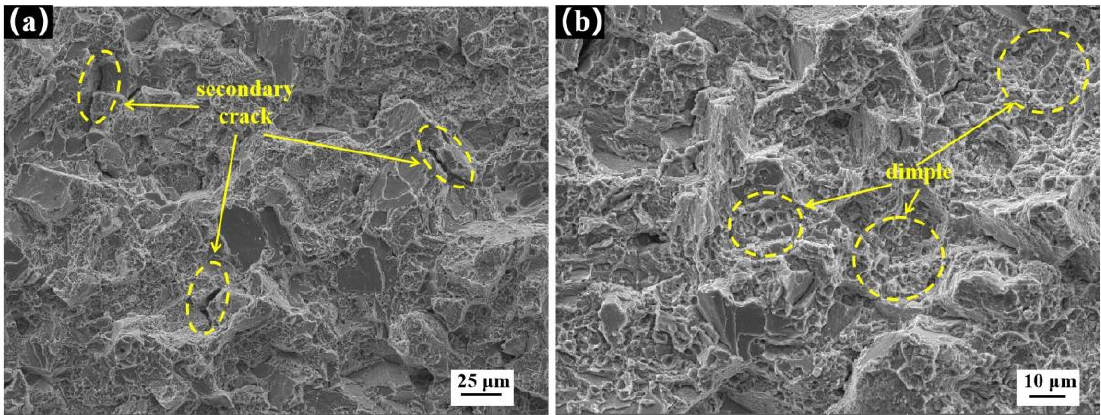
Figure 6. Tensile fracture morphology: ( a ) secondary cracks, ( b ) equiaxed dimples.